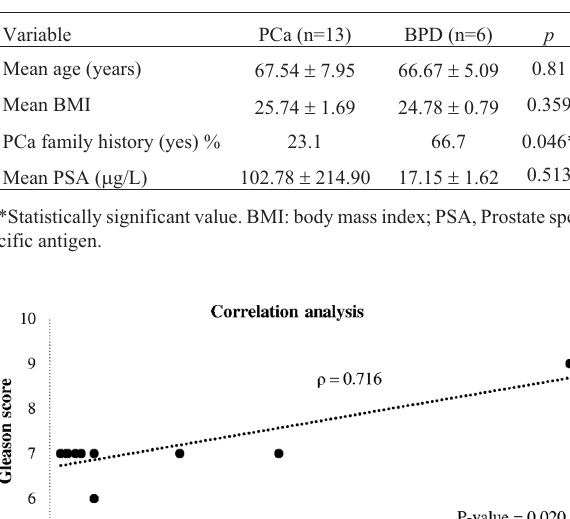
Table 1 - Clinical characterization of prostate cancer (PCa) and benign prostate disease (BPD)